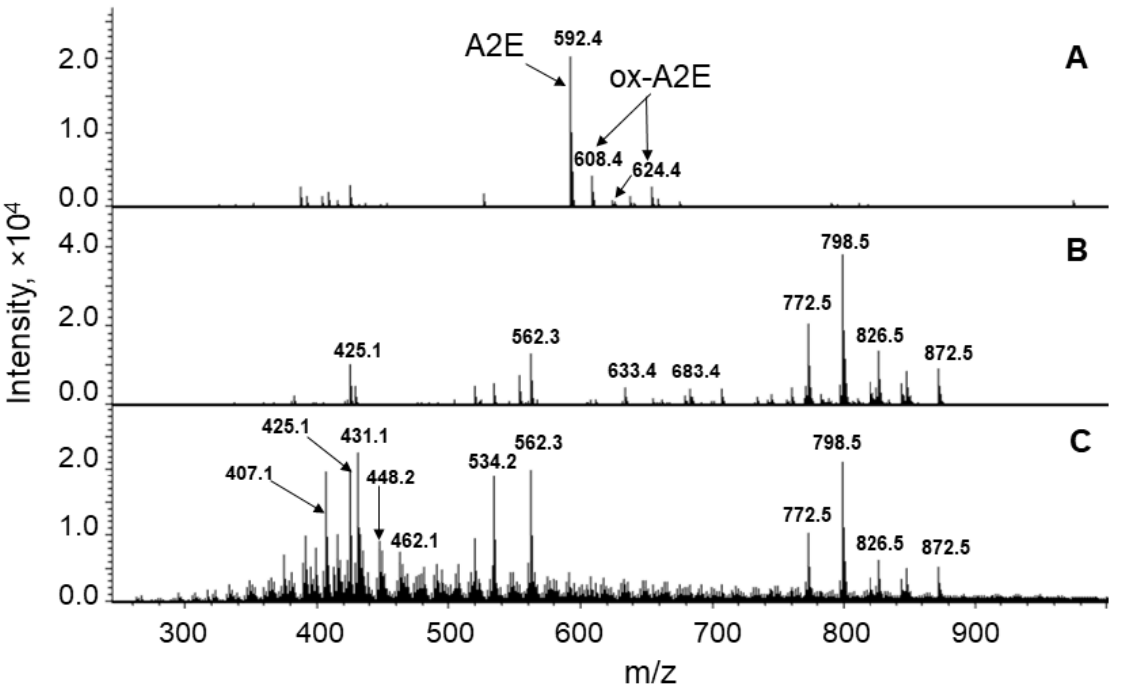
Figure 4. Mass spectrometry analysis of A2E and its singly and doubly oxidized forms ( A ), super- natant from the original lipofuscin granule (LG) suspension ( B ), and supernatant from LG suspension irradiated for 60 min ( C ).